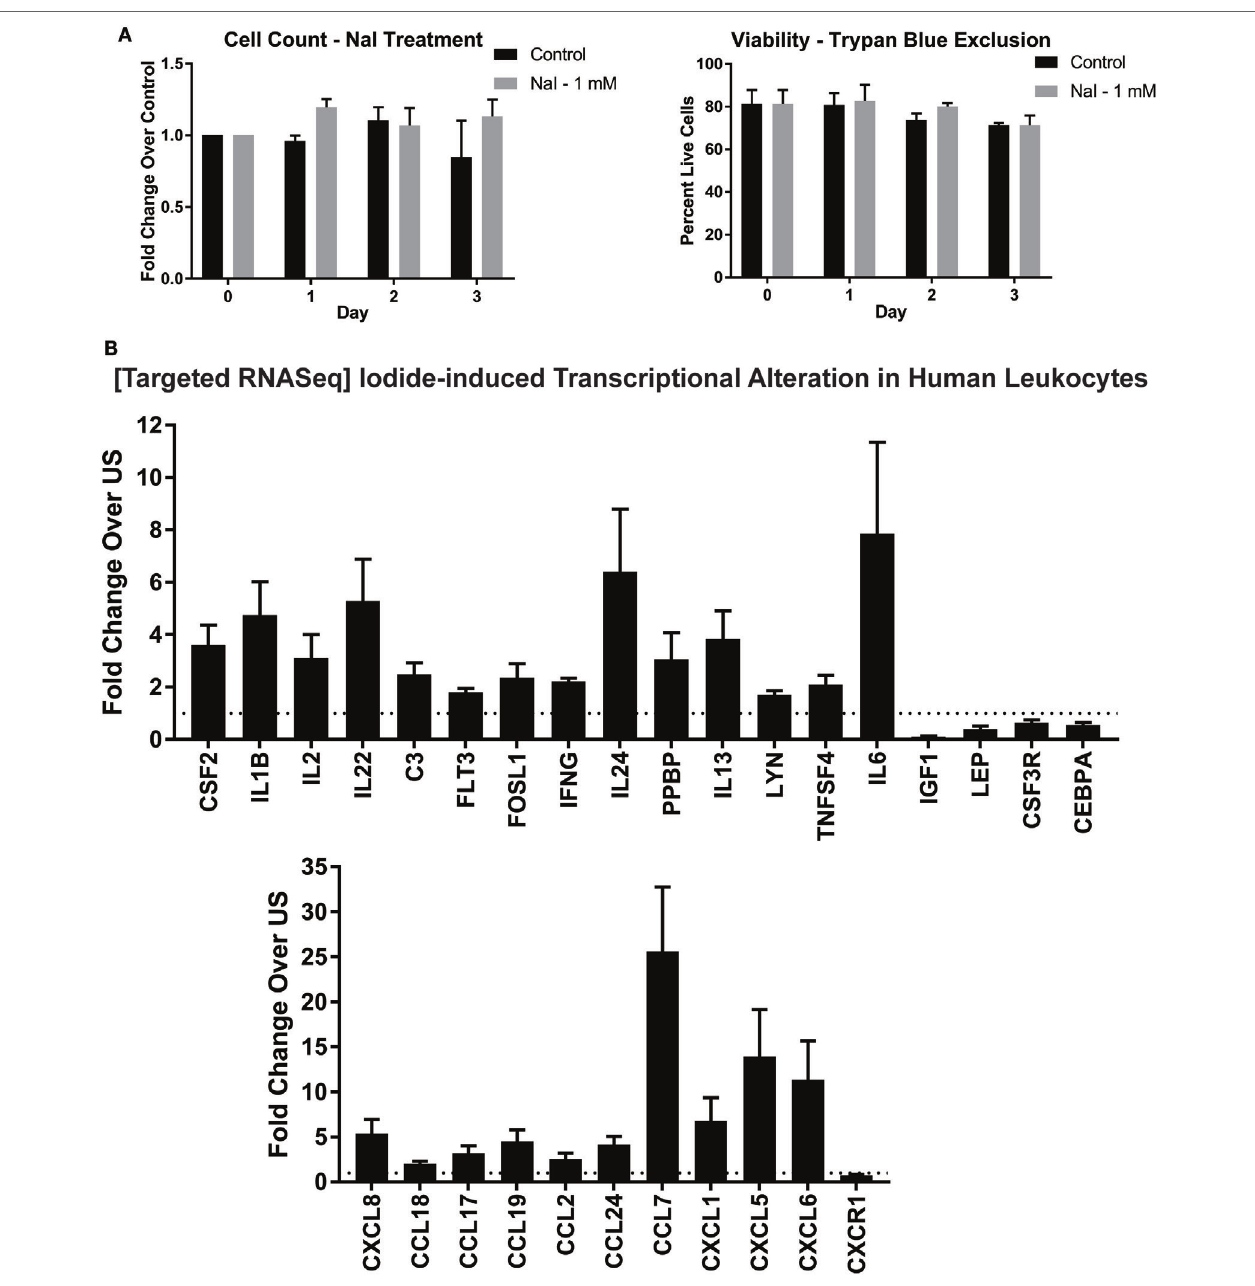
FigUre 2 | Targeted RNASeq analysis of iodide-treated leukocytes via next-generation sequencing. (a) Viability analysis of iodide-treated leukocytes—5 × 10 6 leukocytes were left untreated (control—PBS) or incubated with 1 mM NaI for up to 3 days. Cell counts and viability utilizing trypan blue exclusion were determined with TC20 automated cell counter. (B) Targeted RNASeq—leukocytes were left unstimulated with PBS or incubated with 1 mM NaI for 48 h, total RNA was extracted, and then targeted RNASeq libraries were created for a total of 475 genes. The libraries were indexed (multiplexed) and then loaded onto Illumina MiSeq sequencer. The data were de-multiplexed, and unique molecular tags were identified utilizing Qiagen’s RNASeq bioinformatics software. Total molecular tag counts were normalized to counts of 10 housekeeping genes and then quantified based on fold expression relative to each untreated control. Average fold increases were obtained from 5 to 10 independent donors. Genes that were significantly increased or decreased ( p < 0.05) were selected and displayed in bar graph ± SEM of at least five independent donors. See Table S1 in Supplementary Material for quantifications and p